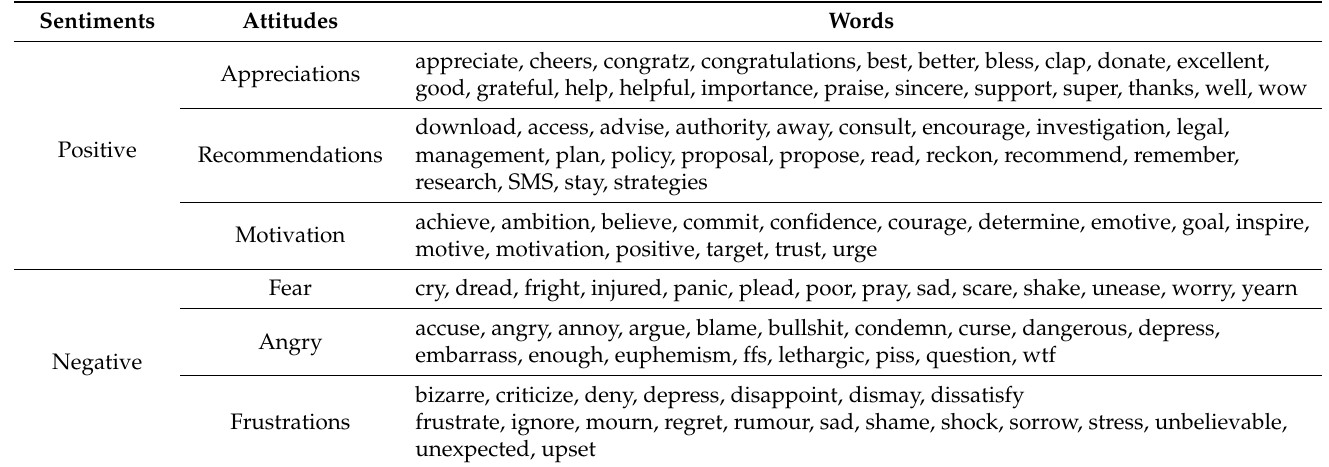
Table 3. A sample of word bags used for attitude analysis.